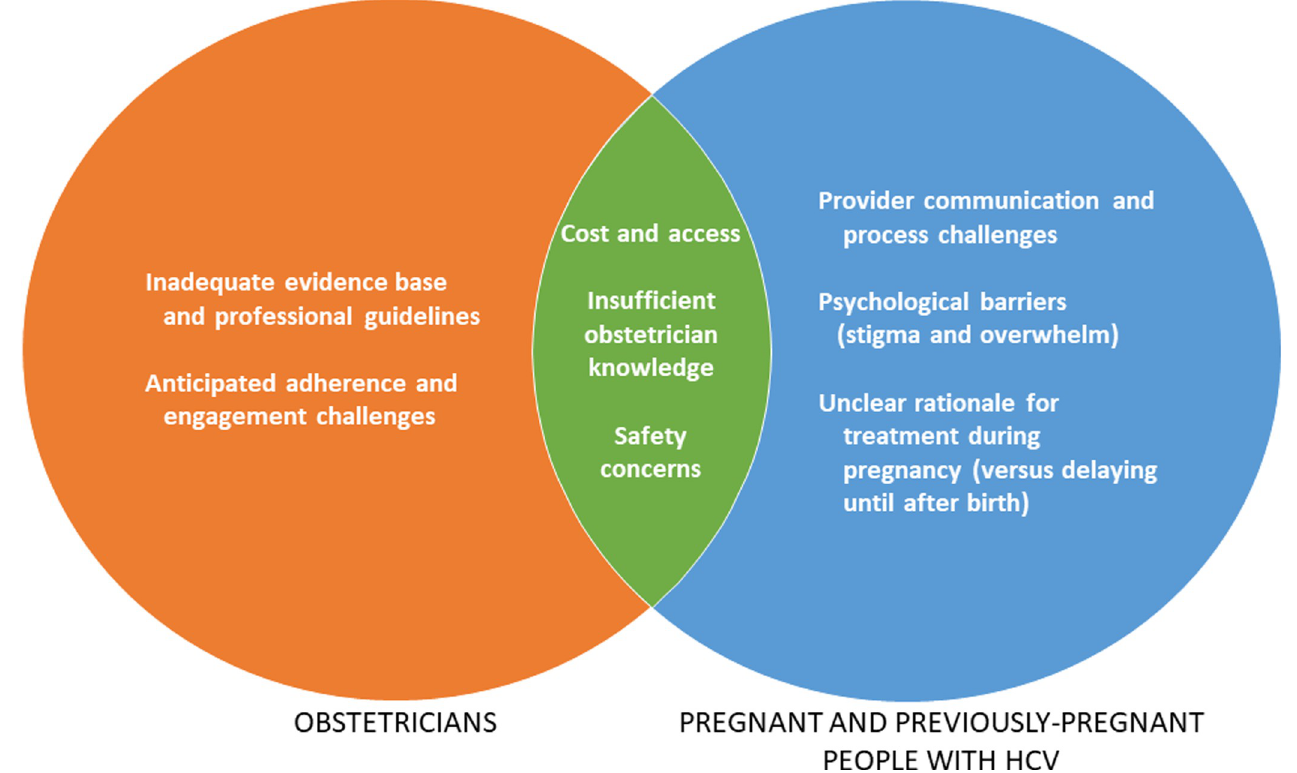
Fig 1. Patient and obstetrician-identified barriers to inclusion of pregnant patients in HCV treatment programs.